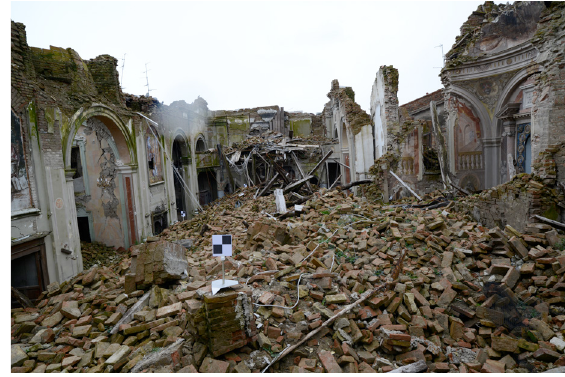
Figure 2: The inside of the church